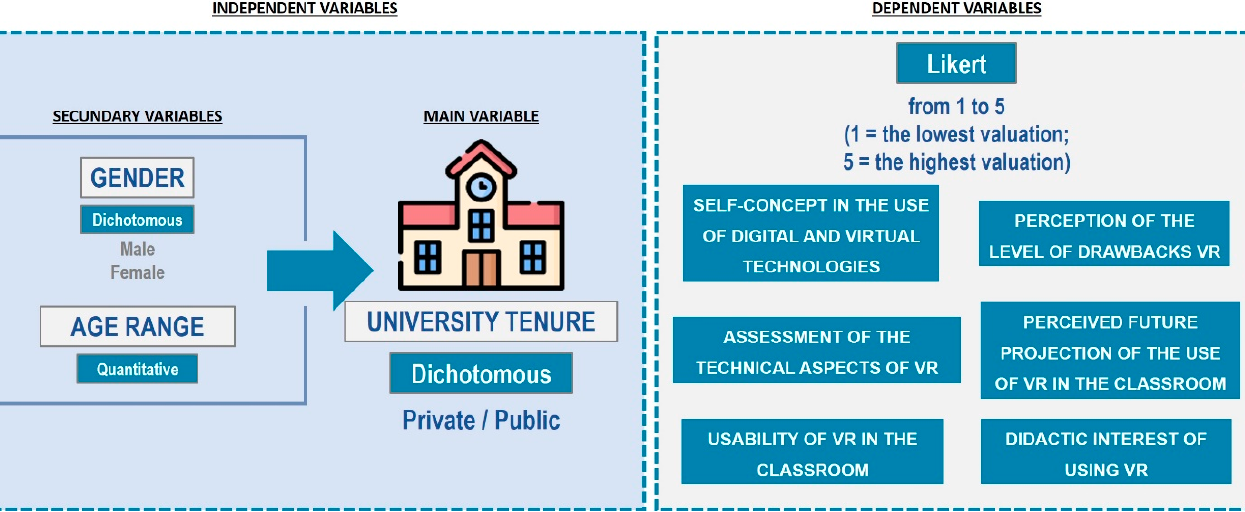
Figure 5. Research variables.